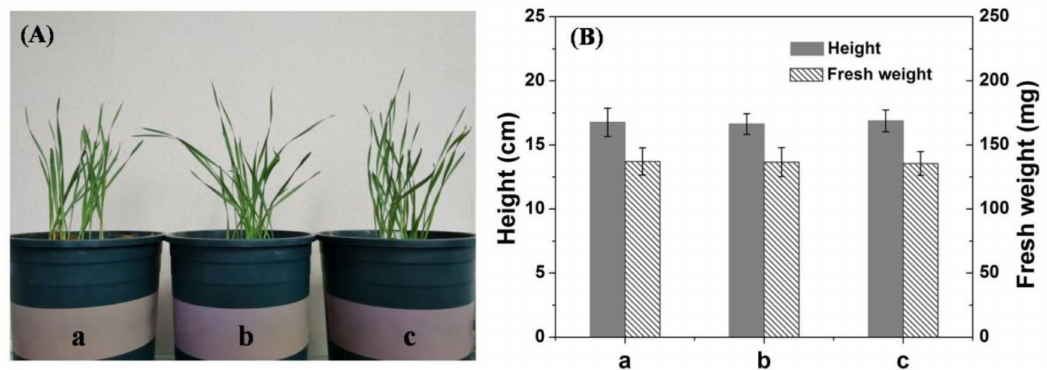
Figure 7. Bioactivity for nontarget plant wheat. ( A ) Photographs and ( B ) height and fresh weight of wheat for ( a ) control with deionized water, ( b ) free 2,4-D and ( c ) 2,4-D-loaded CMCS-DEACMS